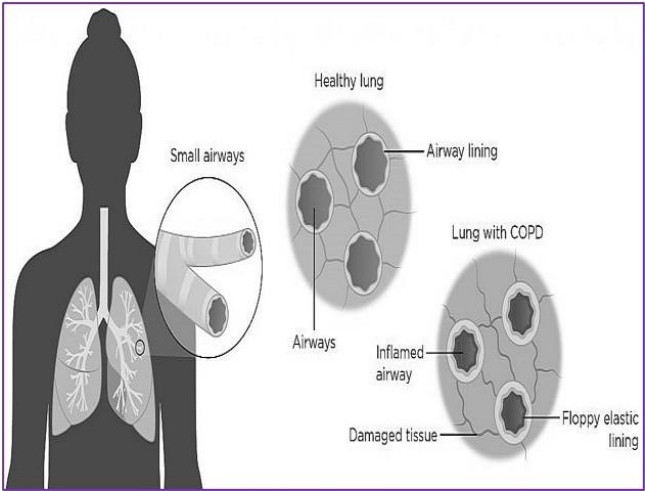
Figure 1. Difference between healthy and damaged lung tissues.